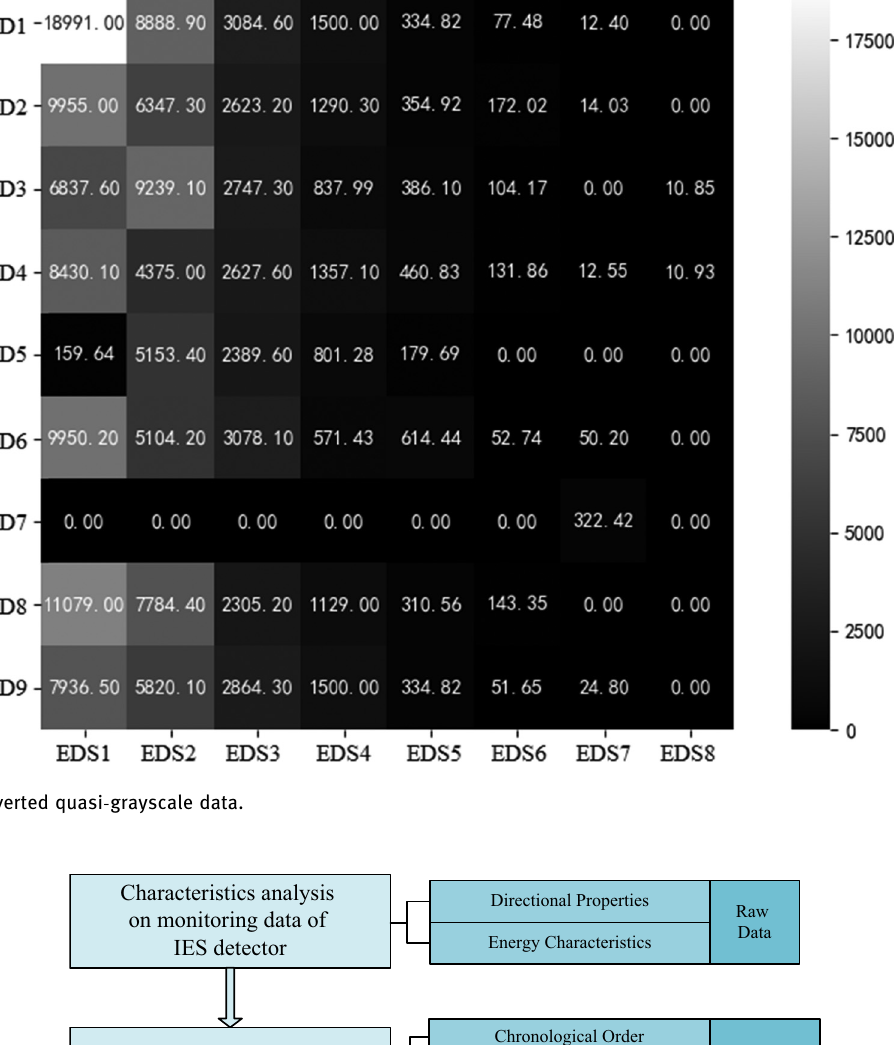
Figure 7: The converted quasi - grayscale data.